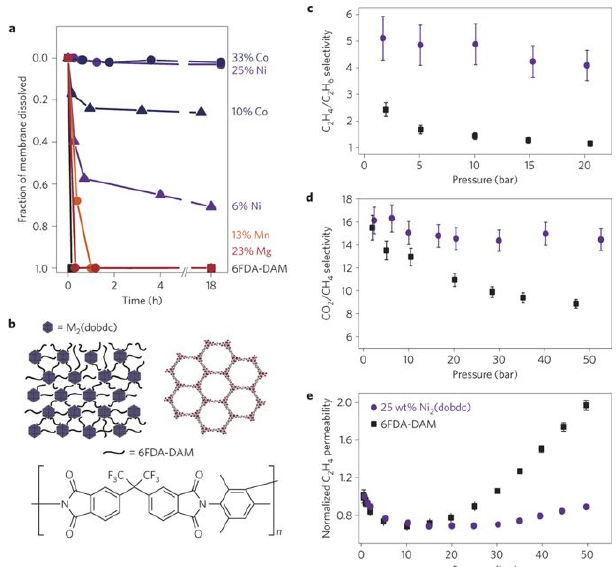
Figure 25. Enhanced membrane stability, reduction in plasticisation, and high mixed-gas selectivity. ( a ), Quantification of membrane stability by Soxhlet extraction in refluxing dichloromethane. The fraction of membrane dissolved corresponds to the mass of membrane remaining after a given period of time in the extractor relative to the initial mass. ( b ) Illustration of the nanocrystal-induced polymer rigidification, along with the structures of M 2 (dobdc) and 6FDA-DAM. Mixed-gas permeation data for a 50:50 C 2 H 4 / C 2 H 6 ( c ) and a 50:50 CO 2 / CH 4 mixture ( d ). Error bars correspond to propagation of uncertainty from the mass spectrometer calibration. ( e ), Single-component C 2 H 4 permeabilities, normalised to the permeability measured at 0.75 bar. Uncertainty in permeability corresponds to propagation of error from uncertainty in the film thickness, area and feed pressure. All permeabilities were collected at 35 ◦ C, and steady-state permeation values were taken after six-time lags. The composition was sampled from permeate that accumulated after steady-state permeation was reached. Permeability and selectivity data correspond to neat 6FDA-DAM (black squares) and 25% Ni 2 (dobdc) / 6FDA-DAM (purple circles). Reprinted with permission from [247], Copyright (2016) Springer Nature.